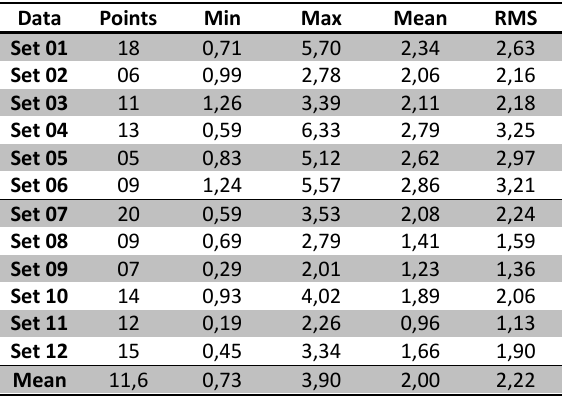
Table 2. Control point residuals in millimeters after the estimation of a seven-parameter transformation using control points measured by tachymetry. Columns: point count, minimum reprojection error, maximum, mean,